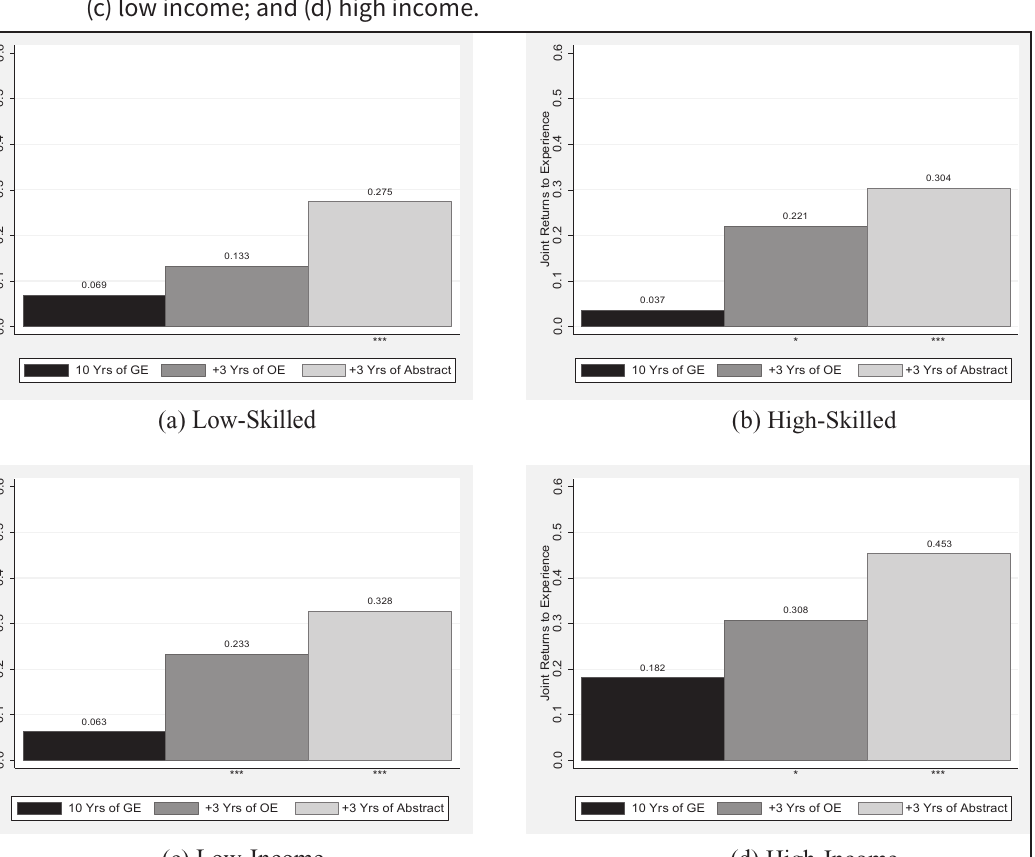
Heterogeneity in returns to experience – two-digit level. Notes: (a) Low-skilled; (b)